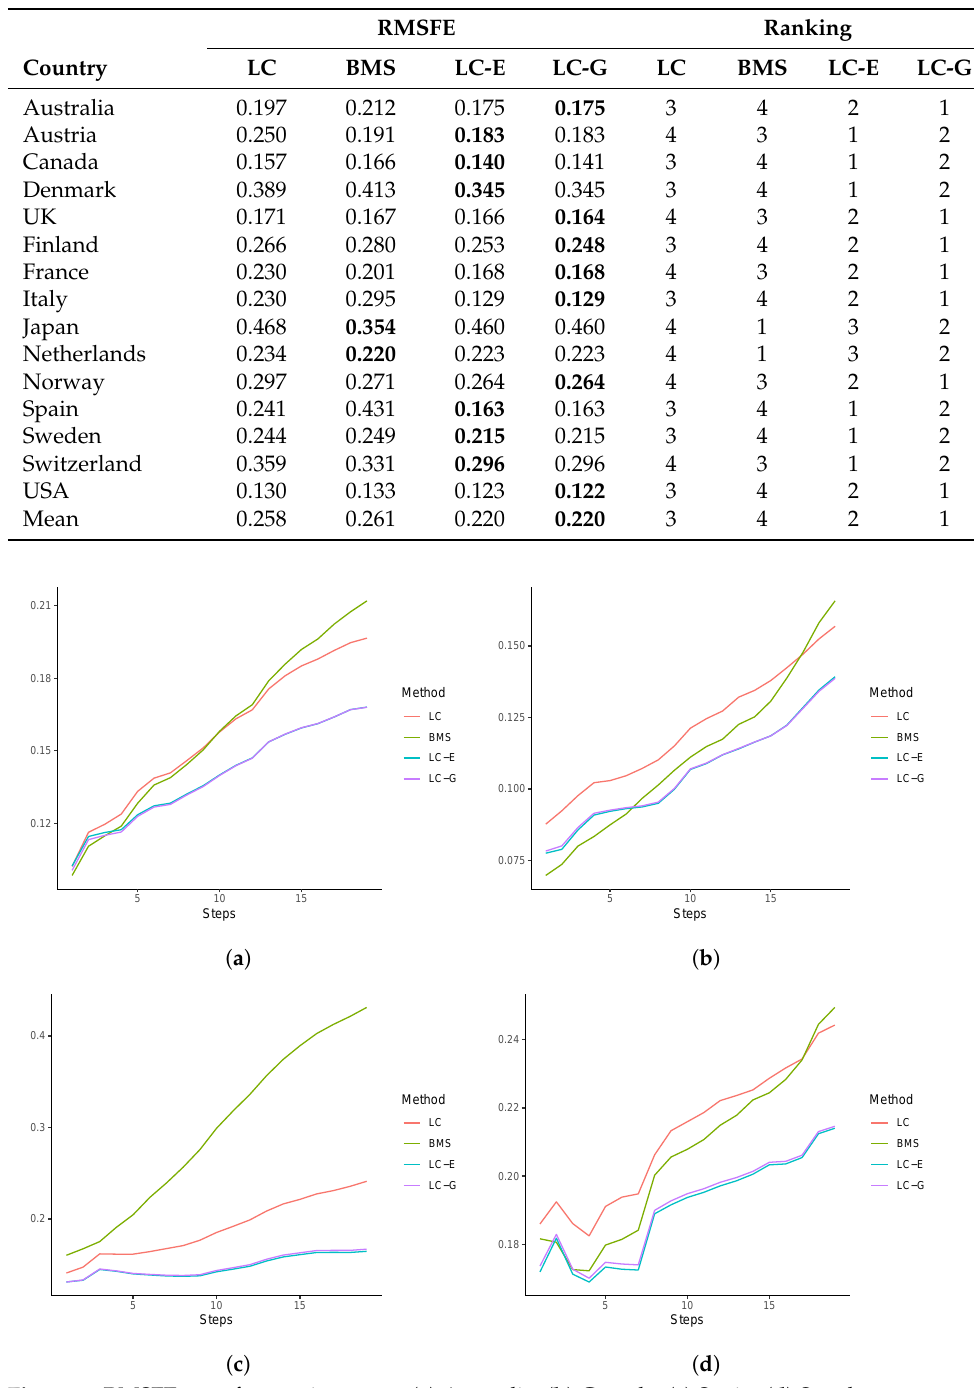
Figure 5. RMSFE over forecasting steps: ( a ) Australia; ( b ) Canada; ( c ) Spain; ( d )